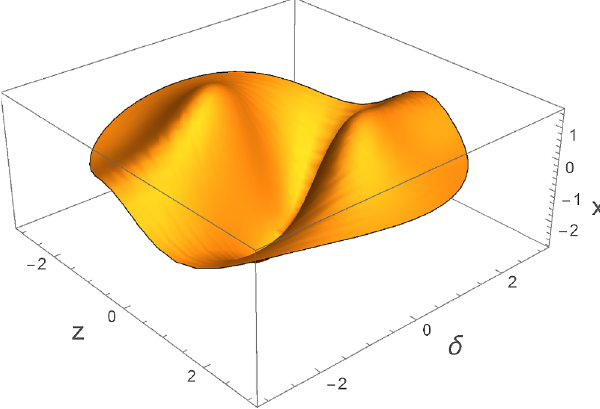
FIG. 12. Eigenvector of an unstable mode with the fastest growth rate. The z and δ axes are in units of σ respectively. x is in arbitrary